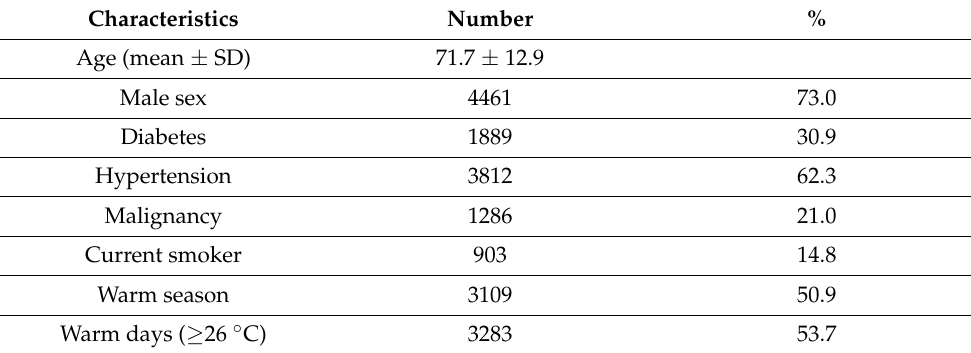
Table 1. Demographic characteristics of patients ( n = 6114).